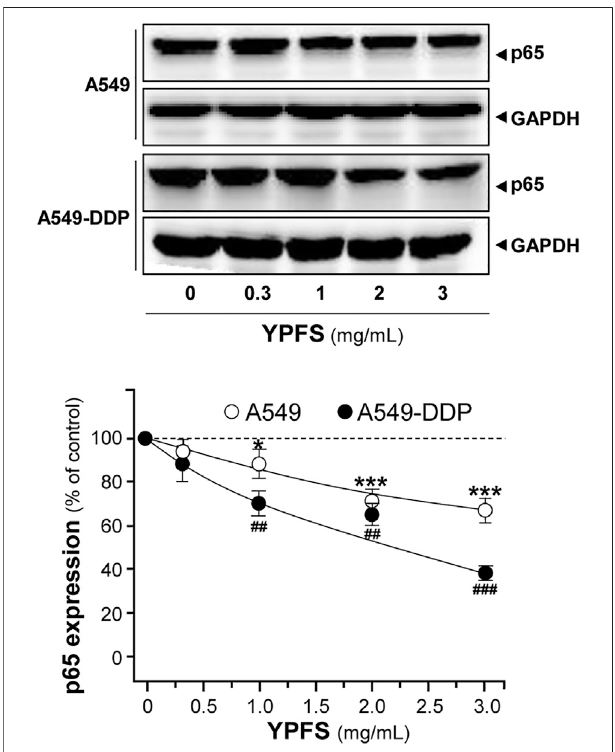
FIGURE 6 | YPFS suppresses protein expression of p65 in cultured A549 and A549-DDP cells. Cultured A549/A549-DDP cells (120,000/well in 100-mmplate)were treated with YPFS for48 h. Celllysates wereanalyzedby meansofwesternblottingasin Figure4 .Mean ± SEMareshown, n (cid:2) 3. * or # , p < 0.05, ** or ## , p < 0.01, *** or ### , p <